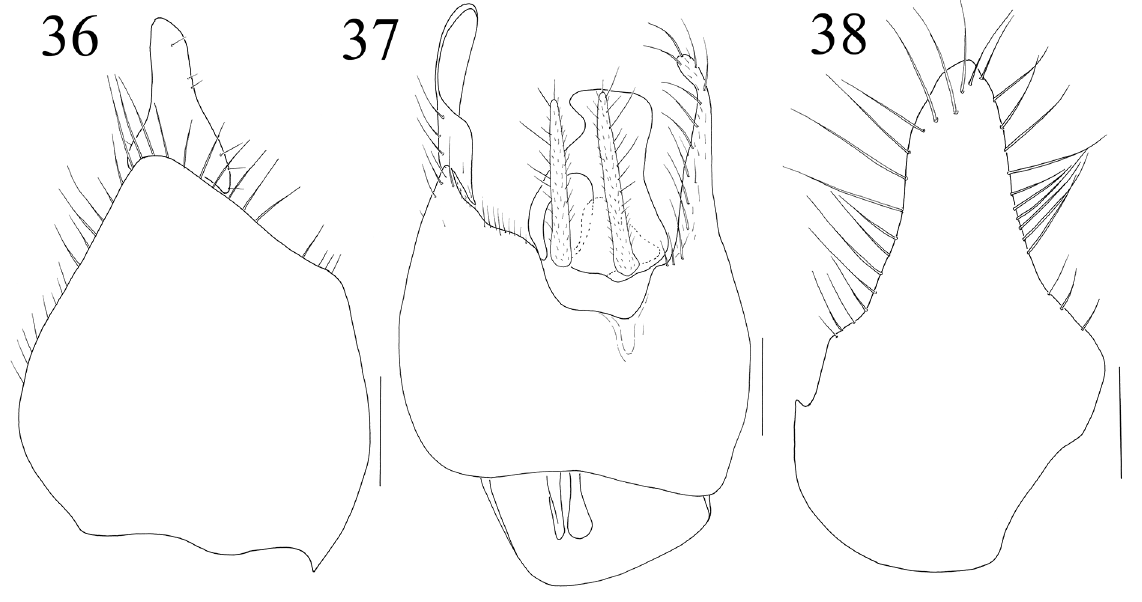
Figs 36–38. Platypalpus yangambensis sp. nov., paratype ♂. 36 . Right epandrial lamella. 37 . Epandrium with cerci, dorsal view. 38 . Left epandrial lamella. Scale bars = 0.1